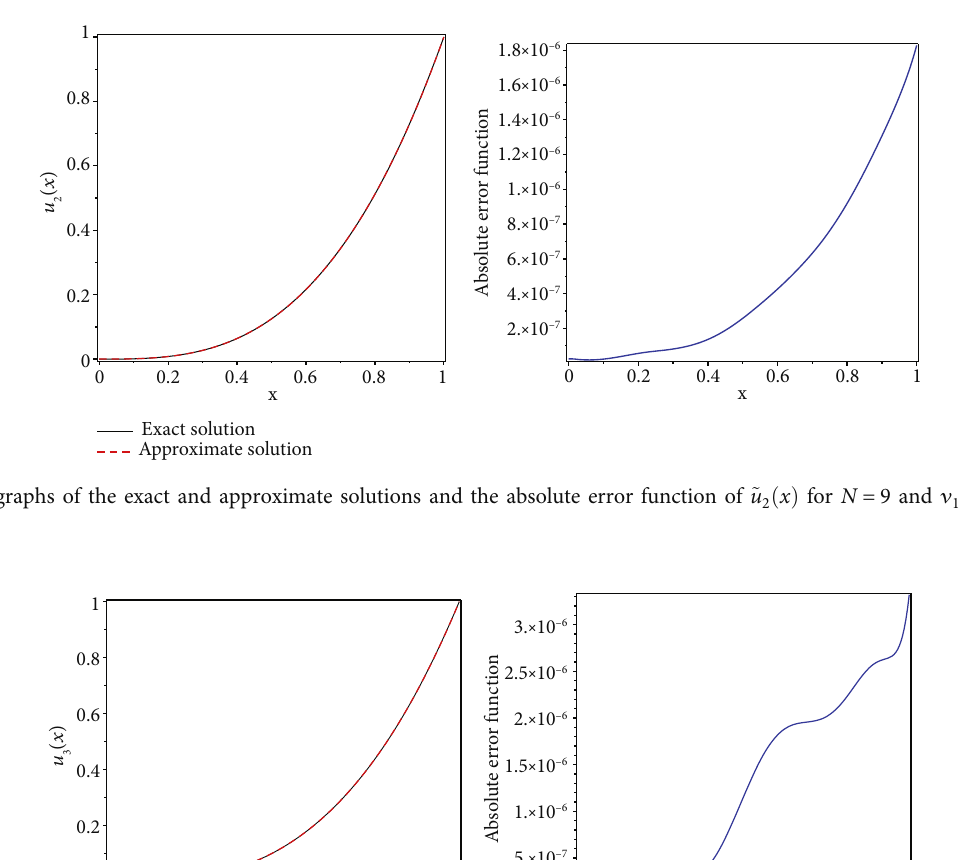
Figure 4: The graphs of the exact and approximate solutions and the absolute error function of ~ u Example 2.